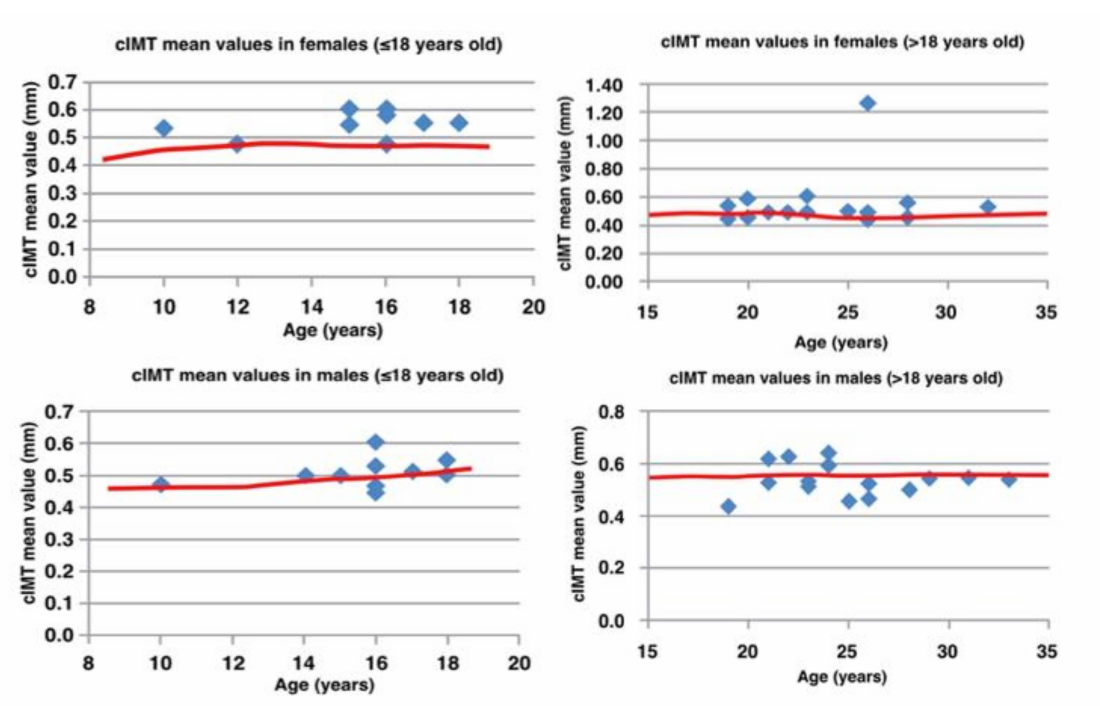
Figure 1. Distribution of cIMT values by age and sex. Values above the 95th centile for age and sex are reported above the red